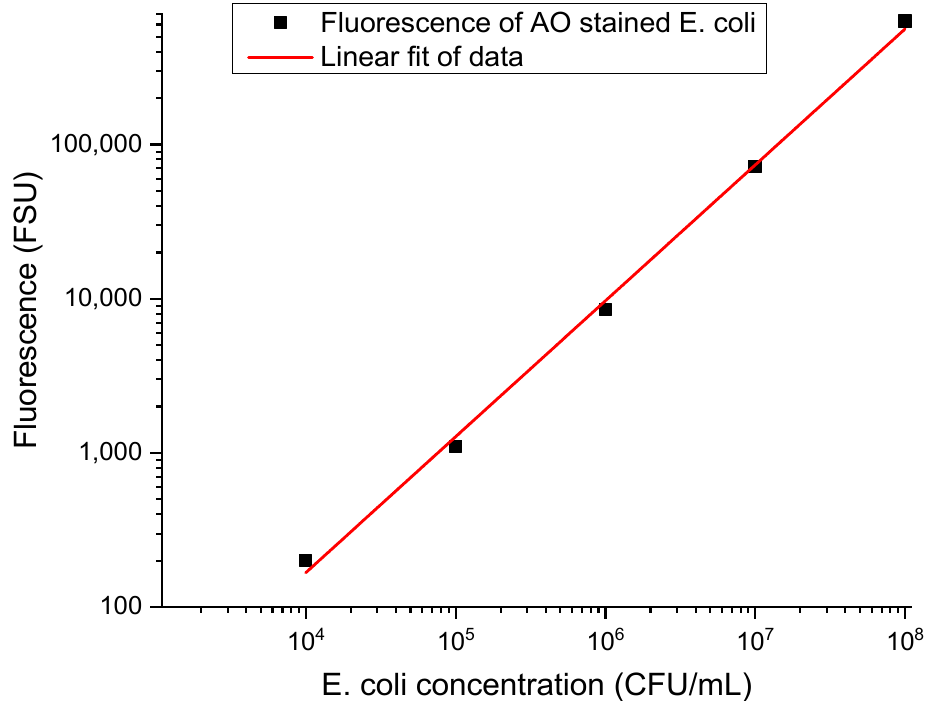
Figure 1. Calibration curve for suspensions of magnetically tagged cells AO-stained with the fluo- rescence signal as a function of the bacterial load.